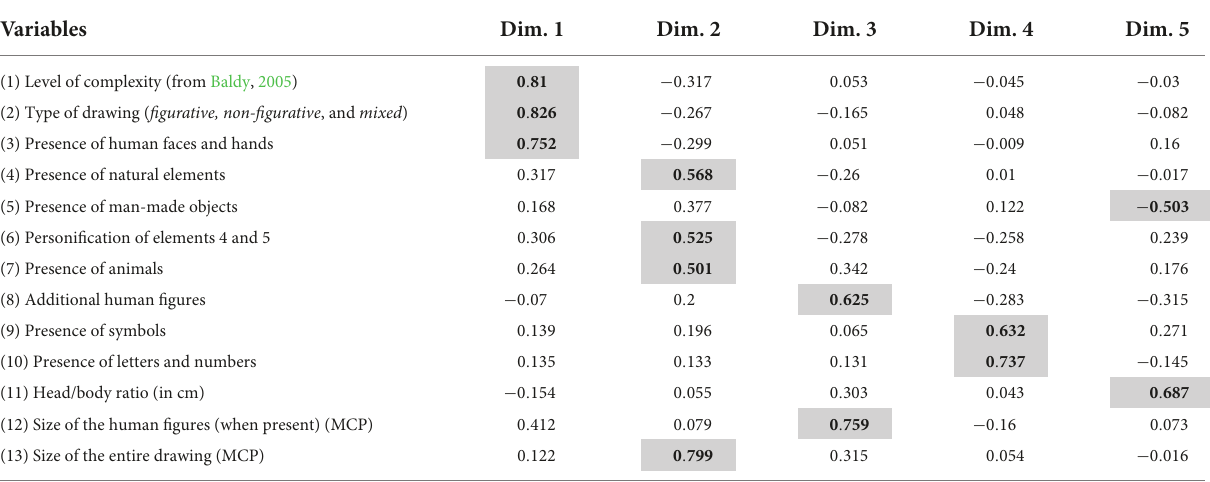
TABLE 1 Metric loading for the five PCA dimensions of our